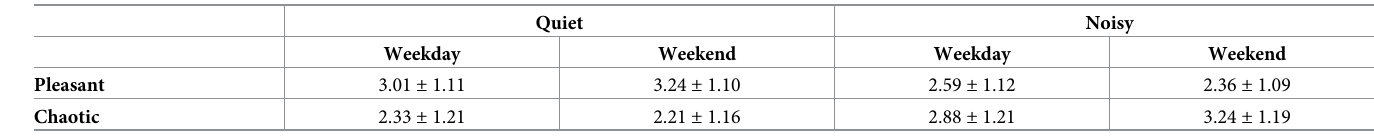
Table 8. Means and SE for scales with significant interaction effect between location and day in the laboratory (N = 544).